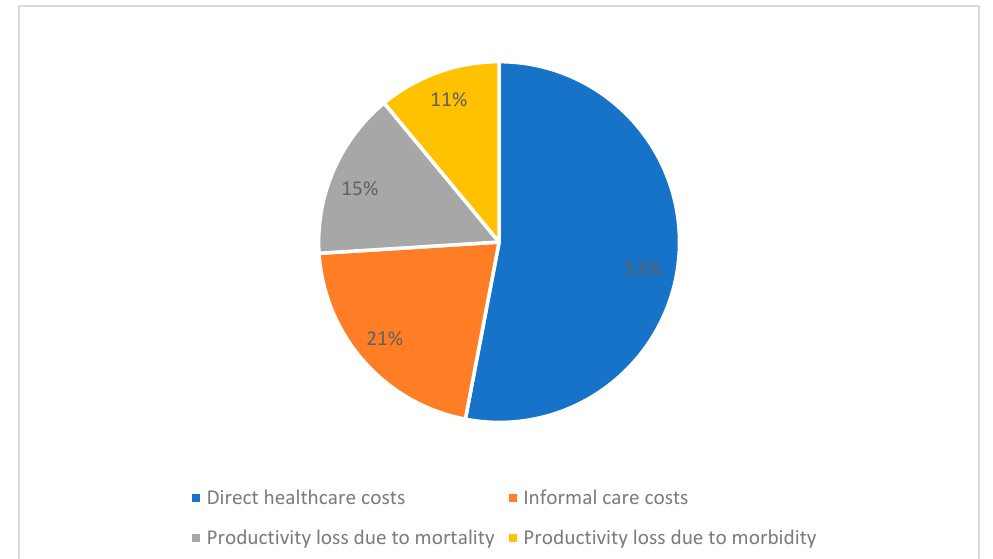
Figure 2. CVD cost shares in the EU (illustration content elaborated and modified from the original work by Timmis et al., 2020 [4]).